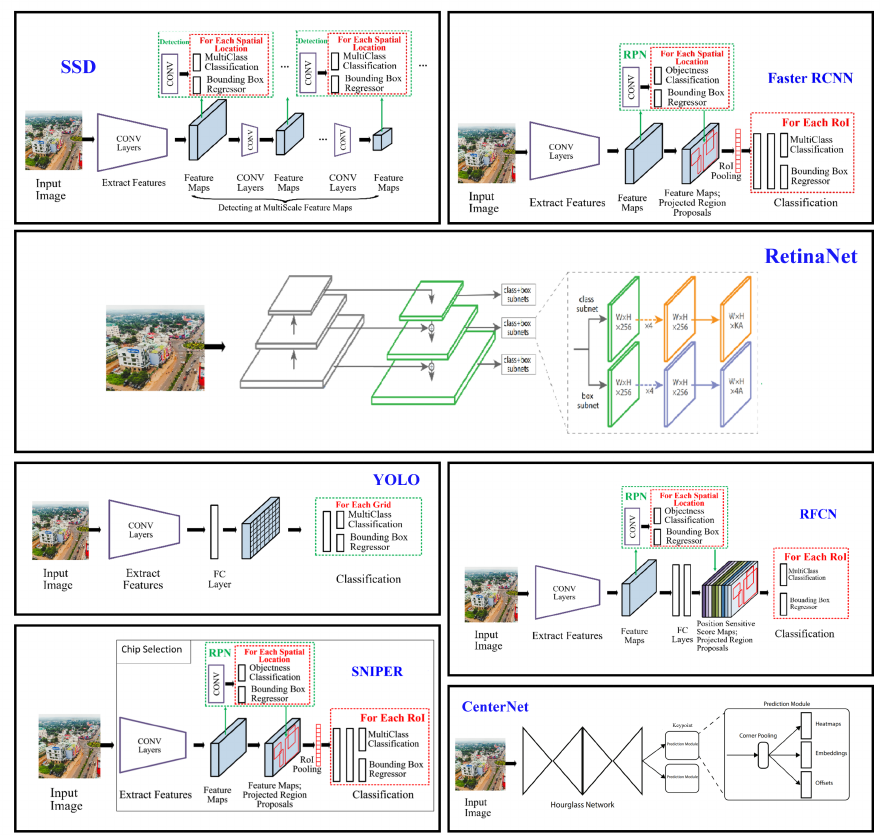
Figure 2. The benchmarked methods adopted in this paper: Faster R-CNN, SSD, RFCN, RetinaNet, SNIPER, YOLOv3, and